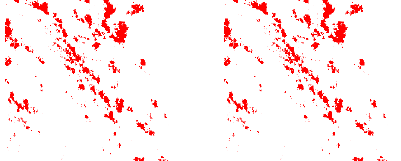
Table 3. Comparison of texture features in dataset